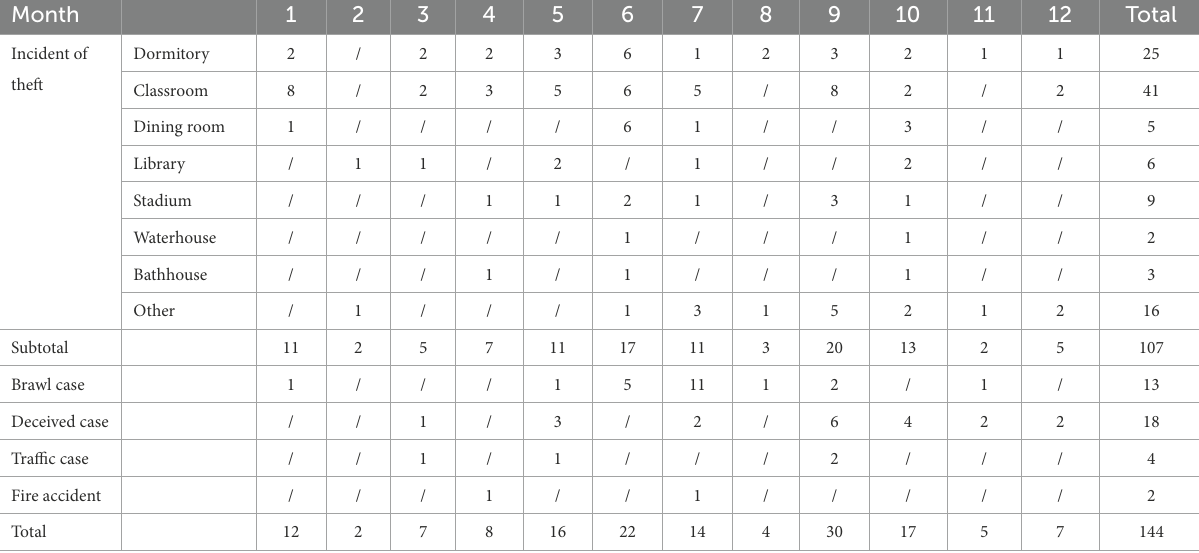
TABLE 1 Statistics on the occurrence of security incidents in a university in 2016.